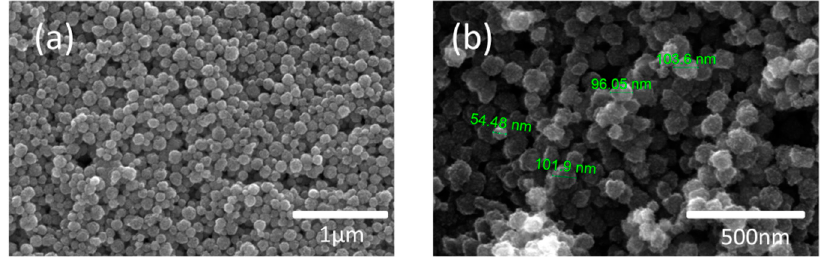
Figure 4. SEM of the ( a ) Fe 3 O 4 magnetic nanoparticles and ( b ) Fe 3 O 4 -PDA–SO 3 H solid catalyst.